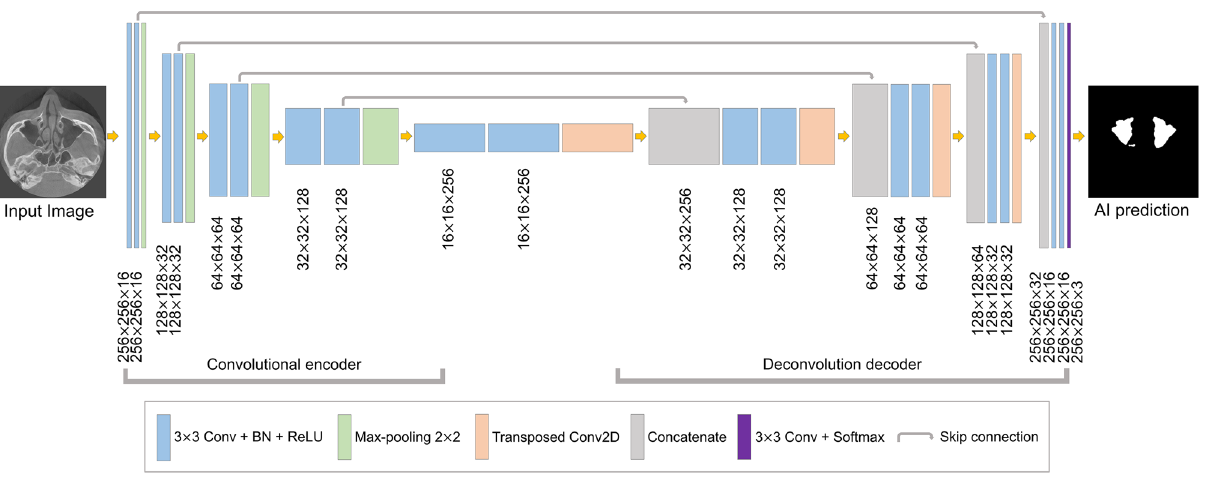
Figure 3. Structure of U-Net based convolutional neural network